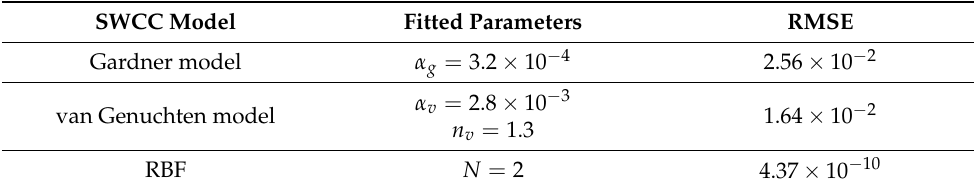
Table 2. The fitted parameters and RMSE in the